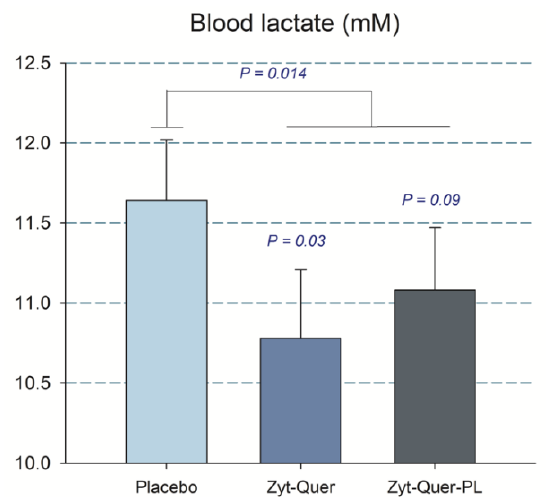
Figure 4. Capillary blood lactate concentration in 20 men. The bars correspond to the mean of the three sprints, after the ingestion of placebo, Zynamite ® (Zyt) combined with quercetin (Quer) or Zynamite ® combined with quercetin and phospholipids (PL). Treatment by sex interaction for the first three sprints p = 0.059. Error bars represent the standard error of the mean. p values: comparison with placebo. N = 20.